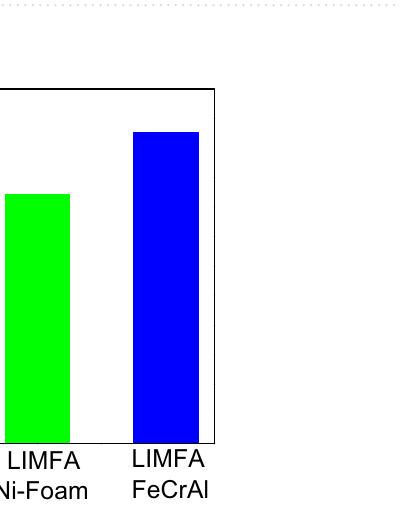
Figure 4. ( a ) Cell discharge performance of Li(Si) and LIMFA FeCrAl, and ( b ) image of the LIMFA FeCrAl cell after discharge.